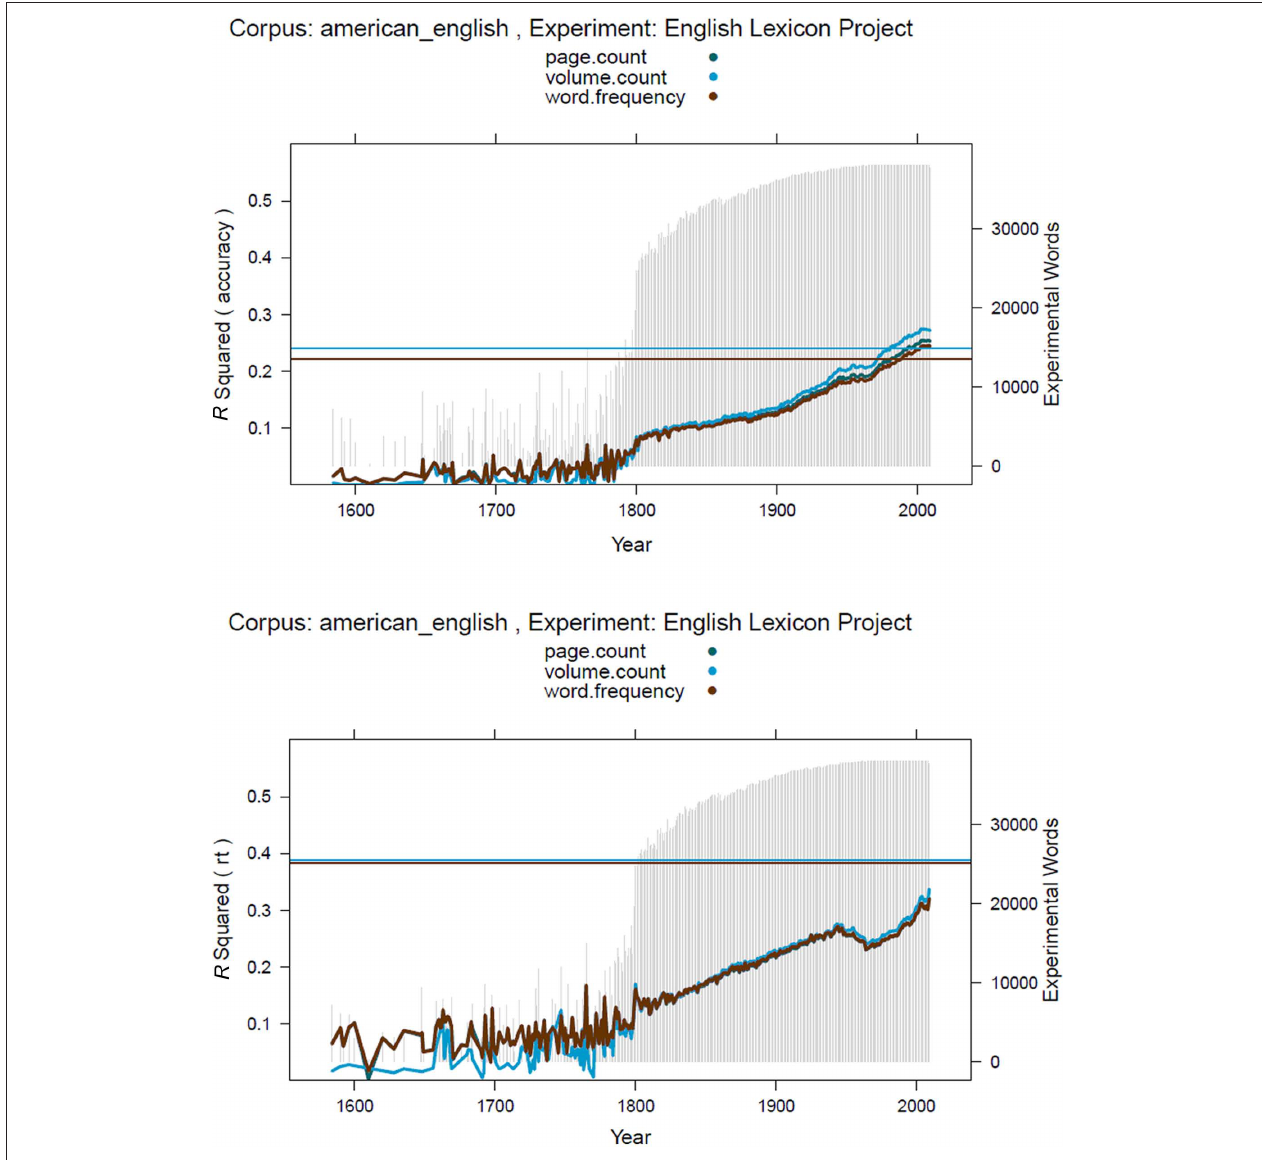
indicate the number of words from the Elexicon Project found in the Google books over the various years (ordinate to the right). The red horizontal line indicates the percentage of variance explained by SUBTLEX-US word frequency; the blue horizontal line indicates the percentage of variance explained by the number of SUBTLEX-US films in which the word appears. RT data based on words with accuracy >